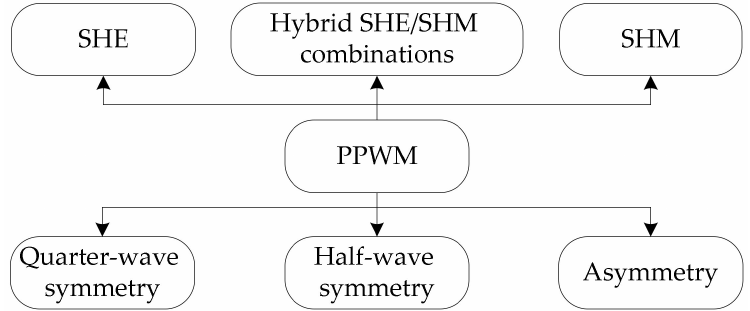
Figure 2. Classification of common PPWM types and